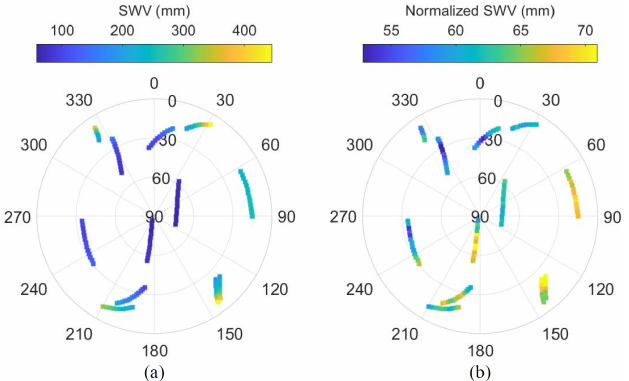
Figure 4. Skyplots of ( a ) SWV and ( b ) normalized SWV on 20 April 2016, 14:00 to 15:00 local